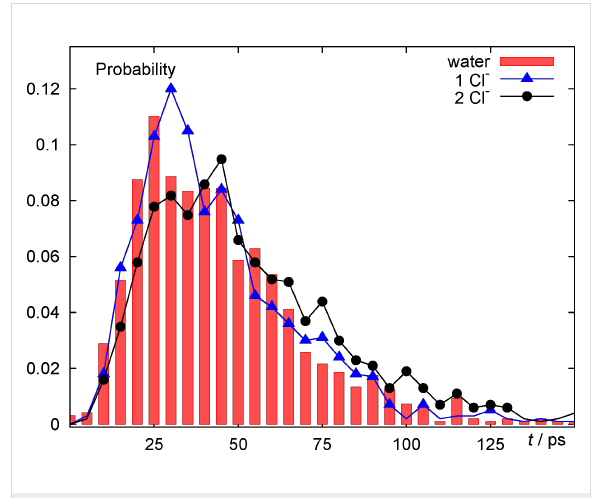
Figure 2: Distribution of discharge times (represented as probabilities to observe discharge within a 5 ps time interval) for a system of pure water (red boxes), of one fully charged adsorbed Cl − ion (blue trian- gles) and two fully charged adsorbed Cl − ions (black circles). In all three cases the total surface charge was − 5 e and, consequently, the homogeneous surface charge density corresponded to − 5 e , − 4 e and − 3 e ,